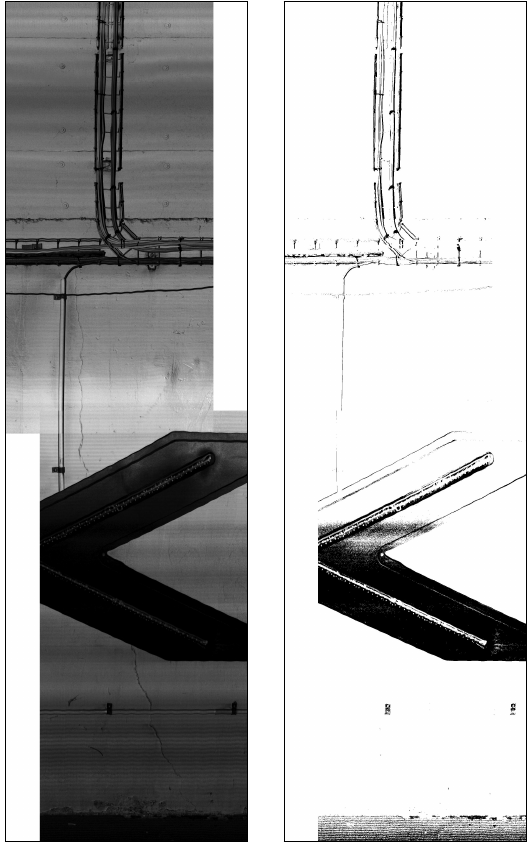
Figure 10. Stitching of the intensity (left) and depth (right) images of a tunnel wall. The translation vector was obtained from images (b) and (c) in figure